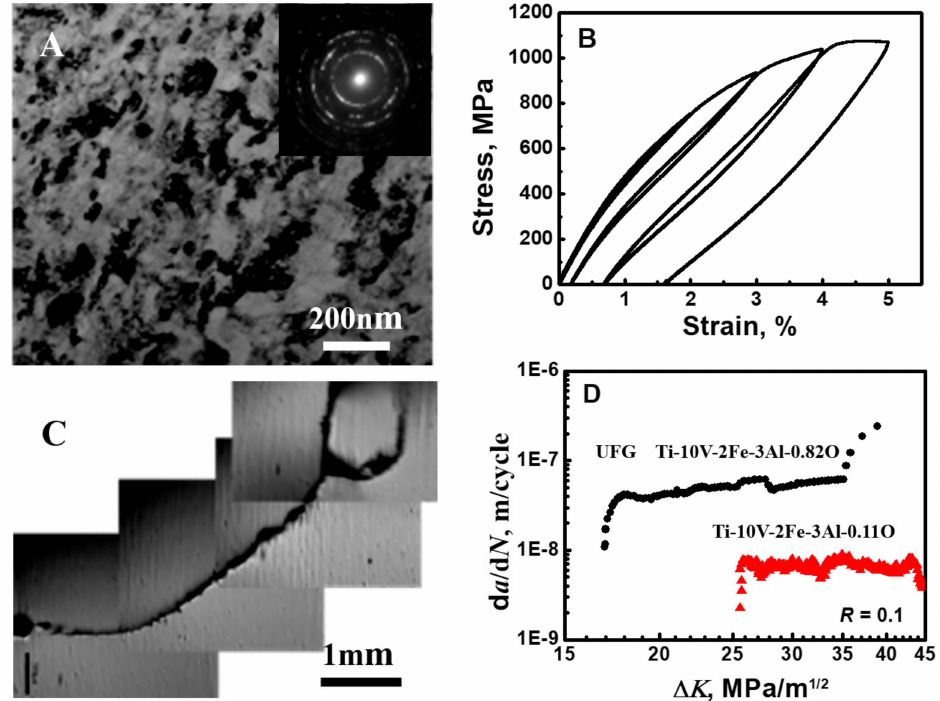
Figure 7. Extreme fatigue damage of ultrafine-grained Ti-10V-2Fe-3Al-0.82O alloy with nano-sized α phase. ( A ) TEM microstructure and the inset SAD pattern. ( B ) The nonlinear elasticity. ( C ) Specimen after three-point bending fatigue test. ( D) Fatigue crack growth rate vs. stress intensity factor